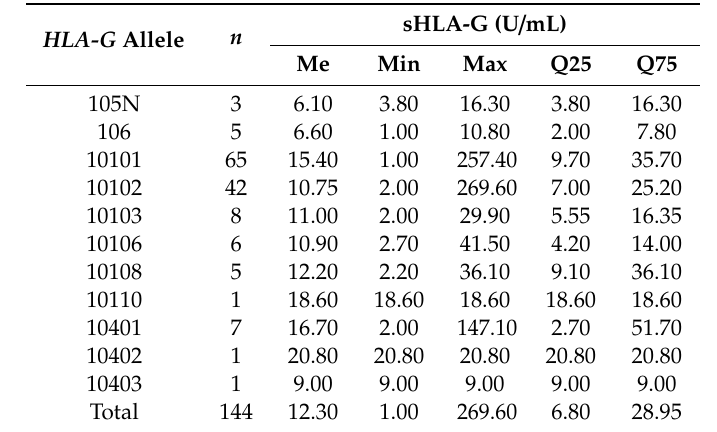
Table 1. The relationship between median (Me), minimum (min), and maximum (max) serum sHLA-G levels (U / mL) with HLA-G alleles in women with an uncomplicated obstetrical history ( n = 72). Results are from Mann–Whitney U